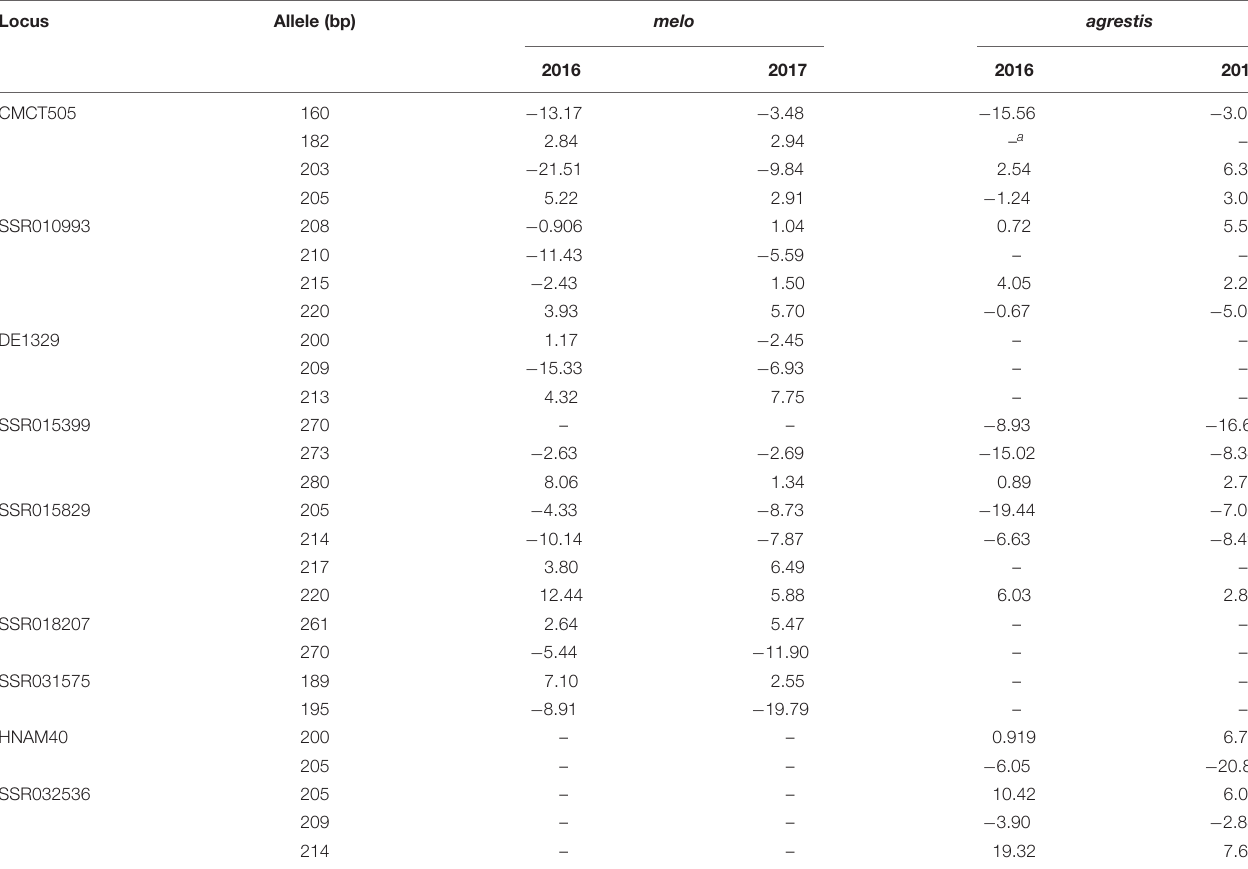
TABLE 3 | Phenotypic effects of the marker alleles significantly associated with chilling tolerance. Locus Allele